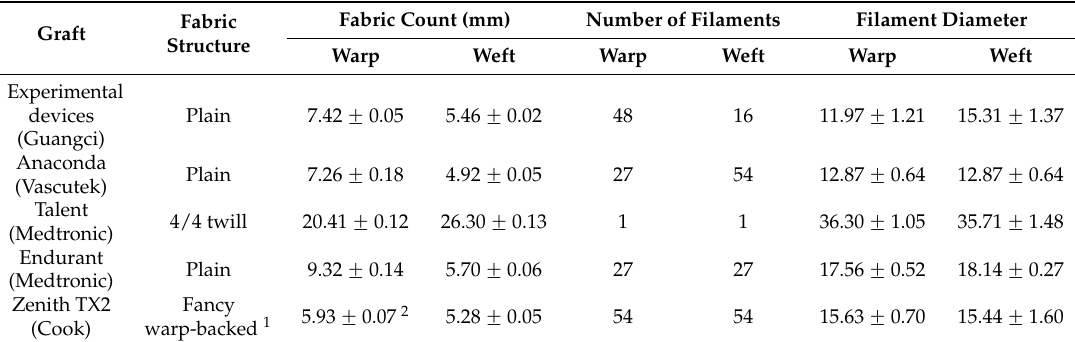
Figure 15. Comparison of the experimental devices to commercially available stent ‐ grafts. They have water permeability similar to those of multifilament devices, whereas the Talent stent-graft has the highest permeability. Table 2. Characteristics of fabrics in selected commercially available stent ‐ grafts.